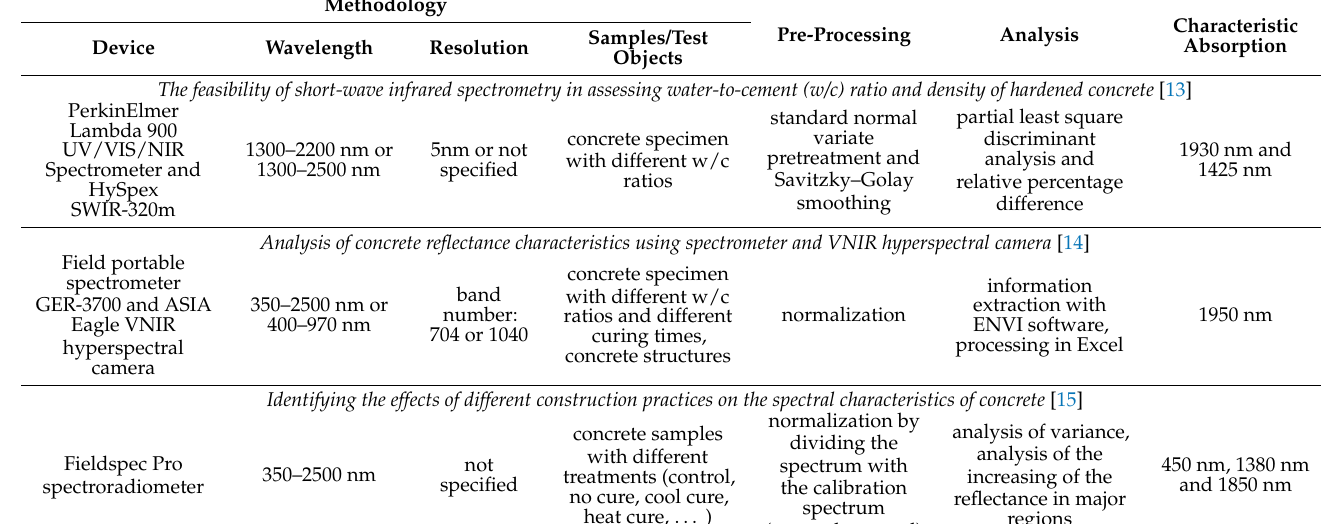
Table 1. Methodology and analysis of concrete quality assessment with spectral imaging from research